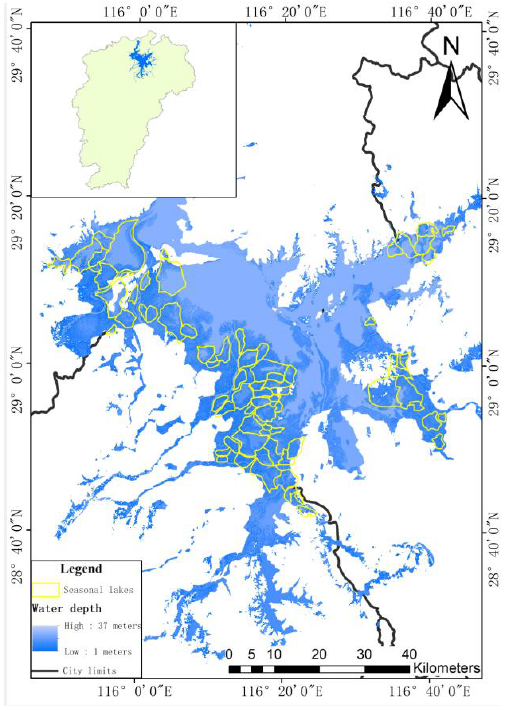
Figure 1. The seasonal lakes in the Poyang Lake region. Table 1. Monthly available